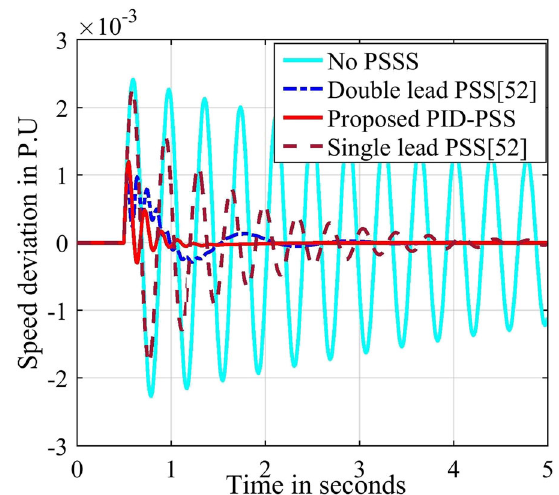
Fig. 19 Comparison of light load ( P = 0.4 p.u. and Q = 0.35 p.u. ) response of Barka-II Power station of the proposed with existing methods to 0.1 p.u. torque disturbance